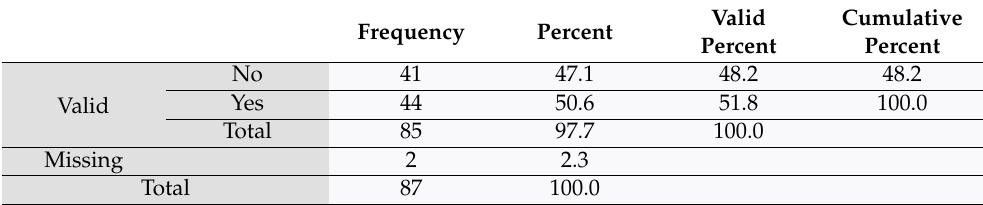
Table 9. Did your TMJ/orofacial pain increase during the pandemic?